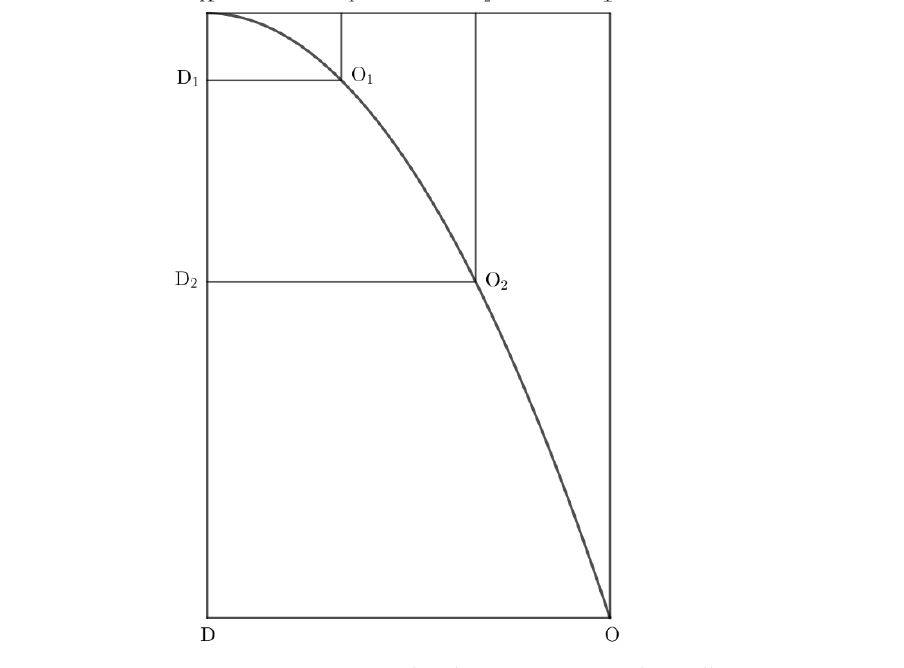
Figure 4. Construction related to Proposition 38 by Wallis.